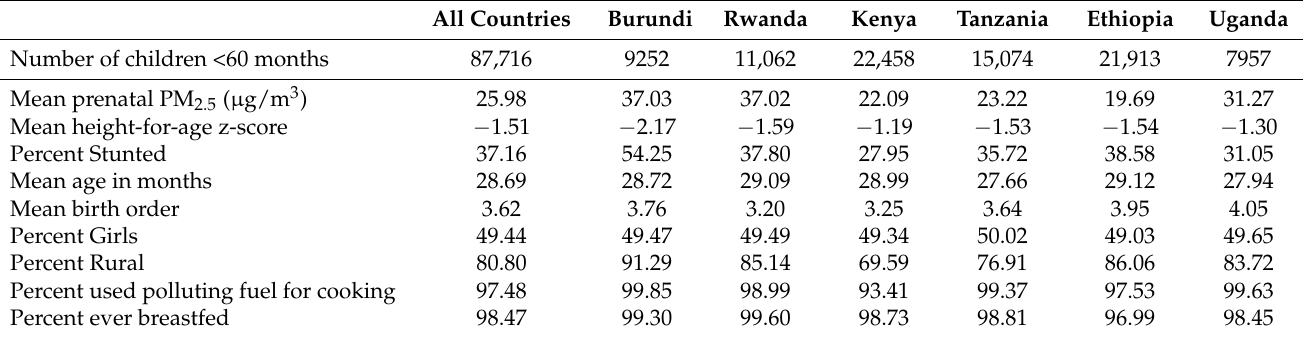
Table 2. Summary statistics of study population characteristics overall and stratified by country.